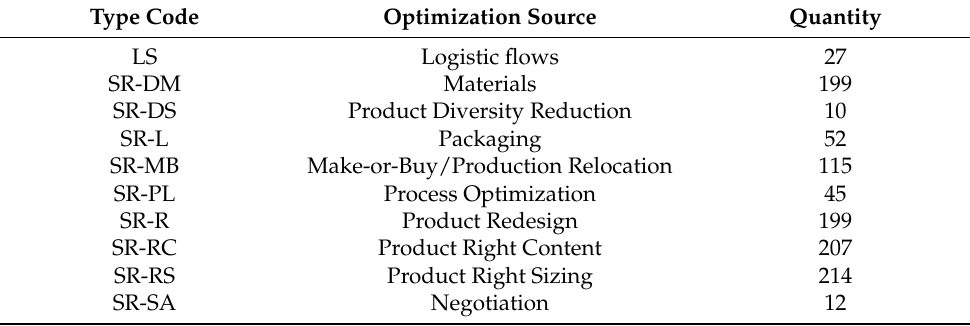
Table 4. Classification types for cost reduction modification database.